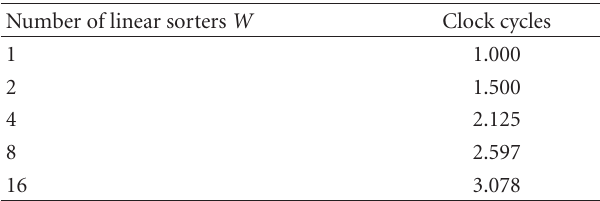
Table 2: Average latency for interleaved linear sorter of width W . Number of linear sorters